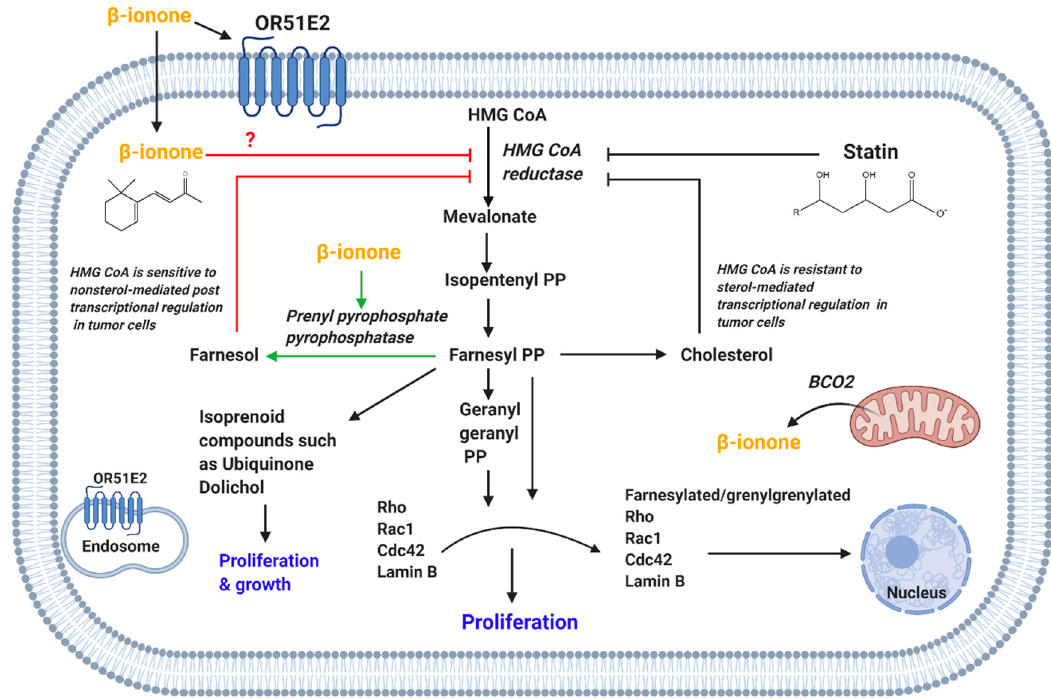
Figure 4. β -Ionone-mediated inhibition of HMG-CoA reductase resulting in anti-proliferative effect and reduction in the level of cholesterol. (OR51E2, olfactory receptor 51E2; BCO2, β -carotene oxygenase-2; HMG CoA, 3-hydroxy-3-methylglutaryl coenzyme A; PP, pyrophosphate).